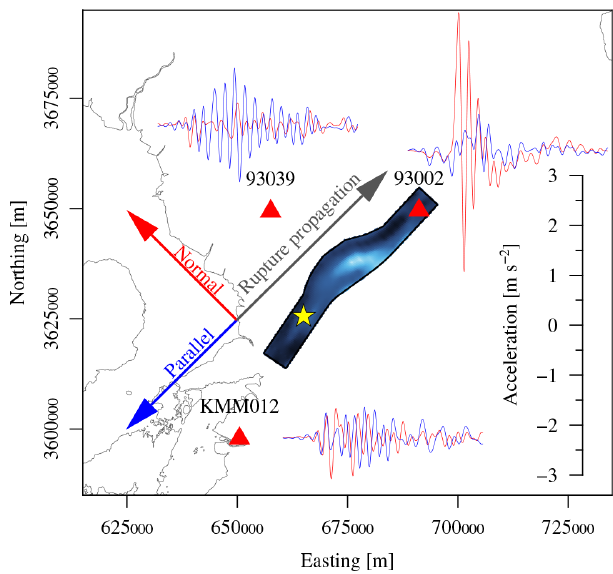
Figure 8. Characteristic waveforms observed in the vicinity of the rupture exhibiting rupture directivity effects. Station 93002 is in the forward-directivity region with a large amplitude pulse on the fault- normal component. Station 93039 is also in the forward-directivity region but with an offset to the rupture. In this region the fault- parallel component has higher amplitudes. The station KMM012 is in the backward-directivity region, and waveforms have longer duration without large amplitudes. The waveforms are low-pass fil- tered at 1.2Hz.